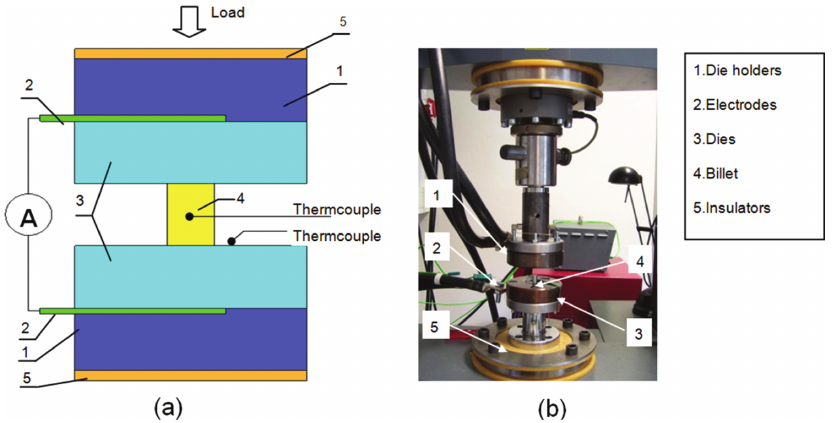
Figure 1: (a) Scheme and (b) photo of the experimental setup.